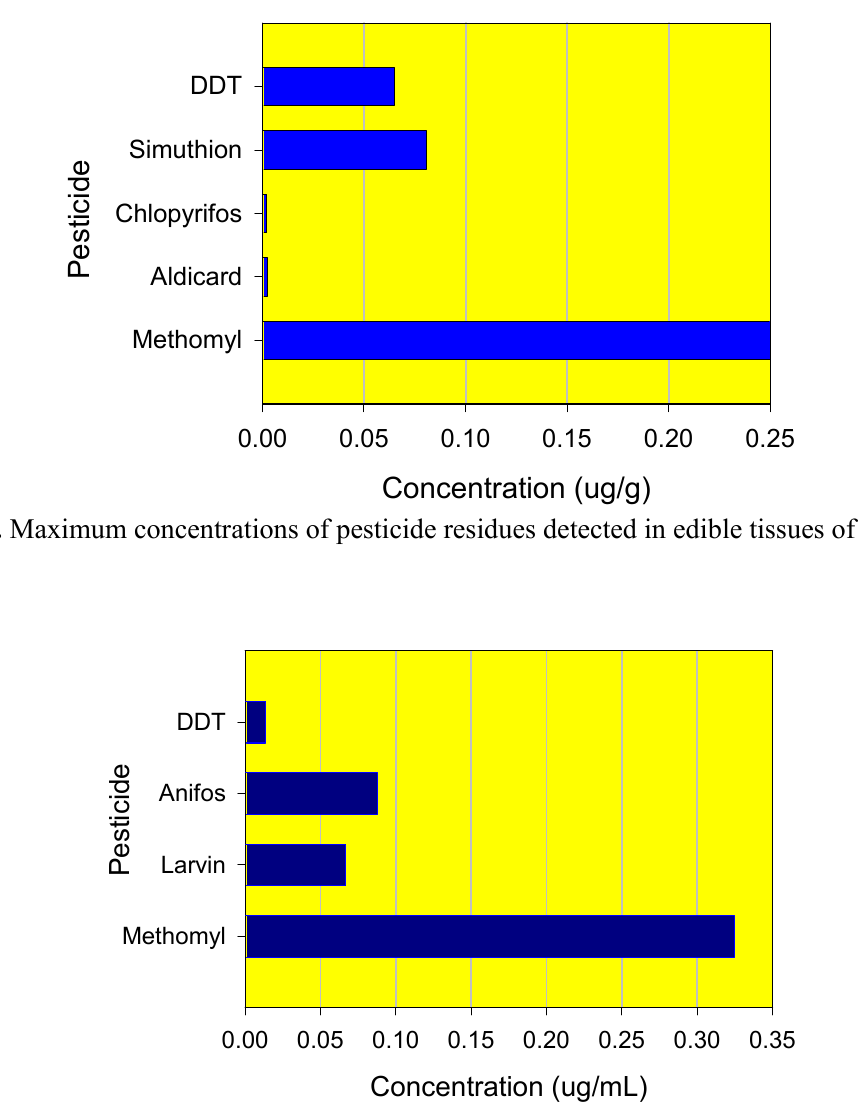
Figure 5. Maximum concentrations of pesticide residues detected in cow or buffalo